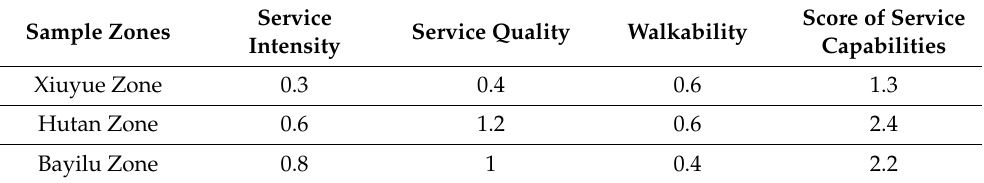
Table 2. Service capabilities of public service facilities. Source: Authors. Sample